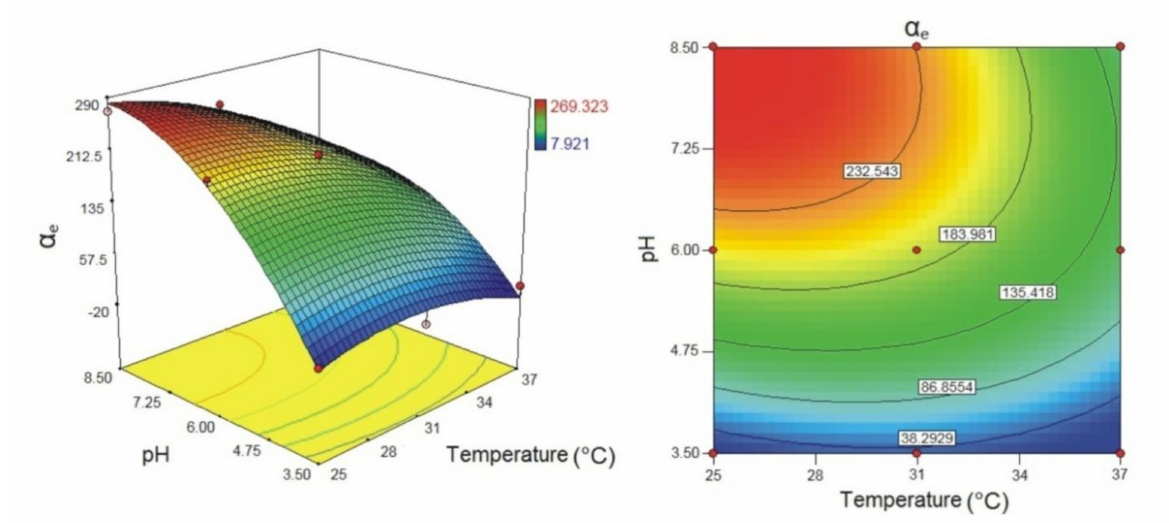
Figure 11. Response surface plot and contour plot for equilibrium swelling ( α e ) of p(NIPAM-co-AA) hydrogel as a function of pH and